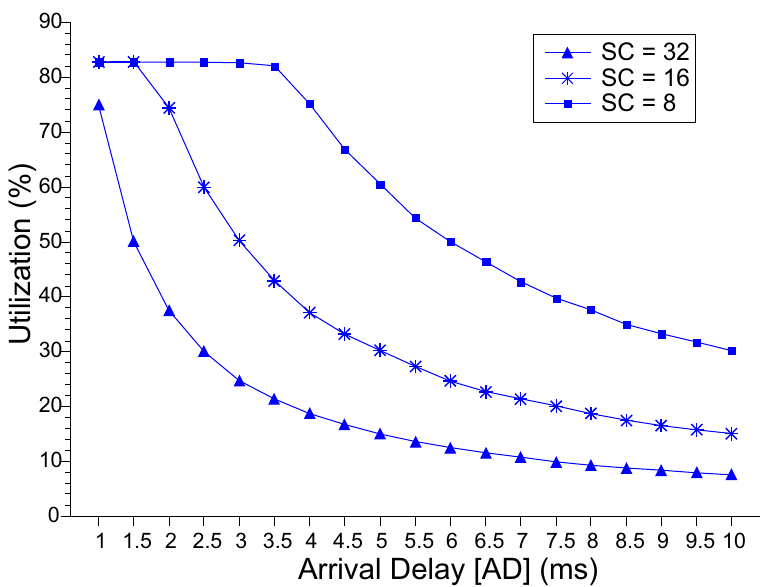
Figure 6. Slaves Server Utilization